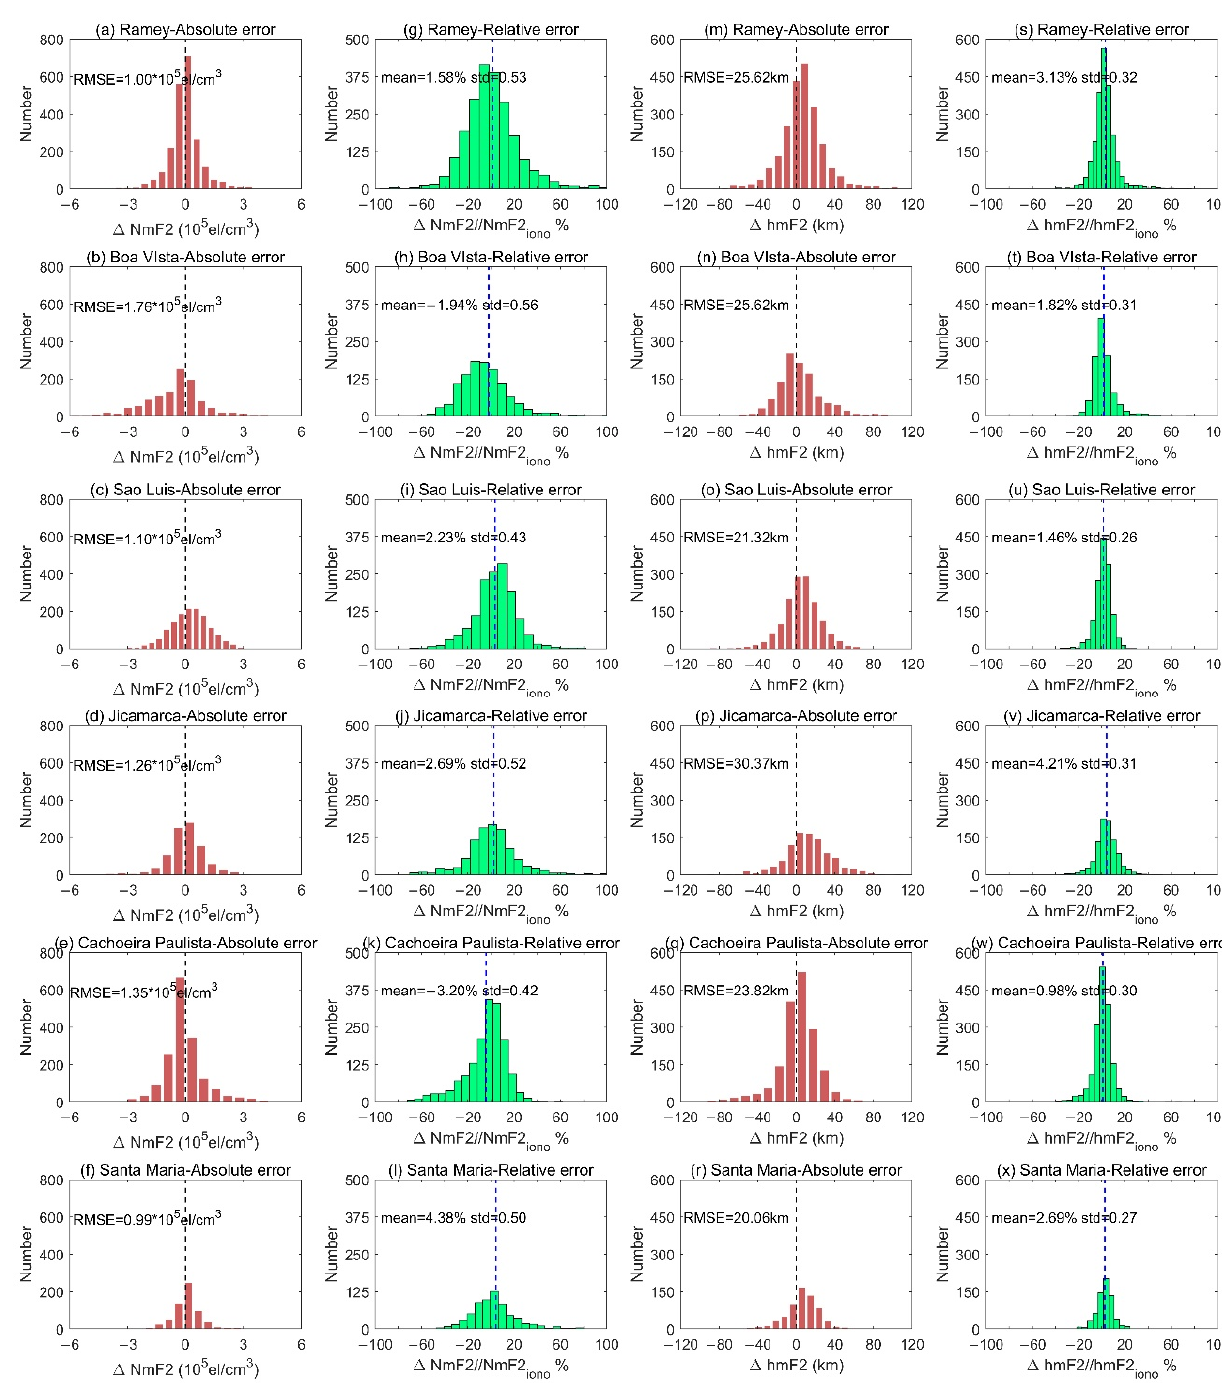
Figure 5. Histograms of the absolute (in red) and relative (in green) errors of NmF2 ( first two columns ) and hmF2 ( the last two columns ) at each station. The black lines in the first and third columns represent (x = 0), and the blue lines in the second and fourth columns represent (x = mean).